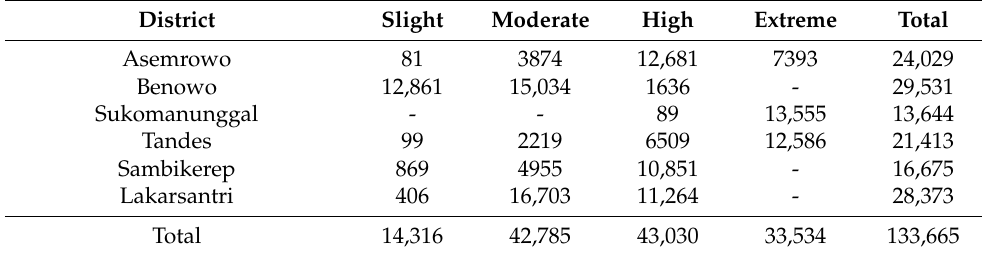
Table 3. The distribution of impacted population by district.